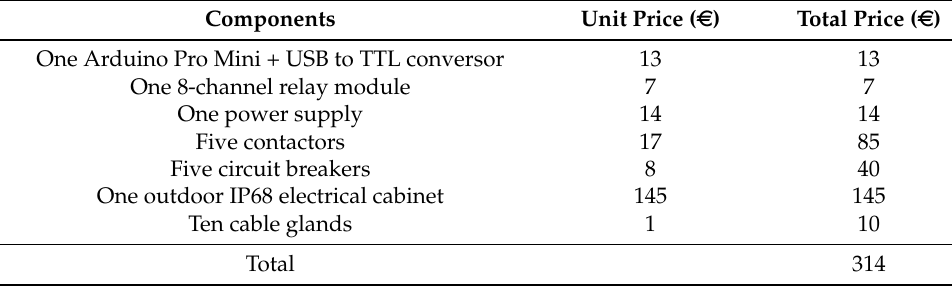
Table 1. Prices of the components used to make the UHU-MUX